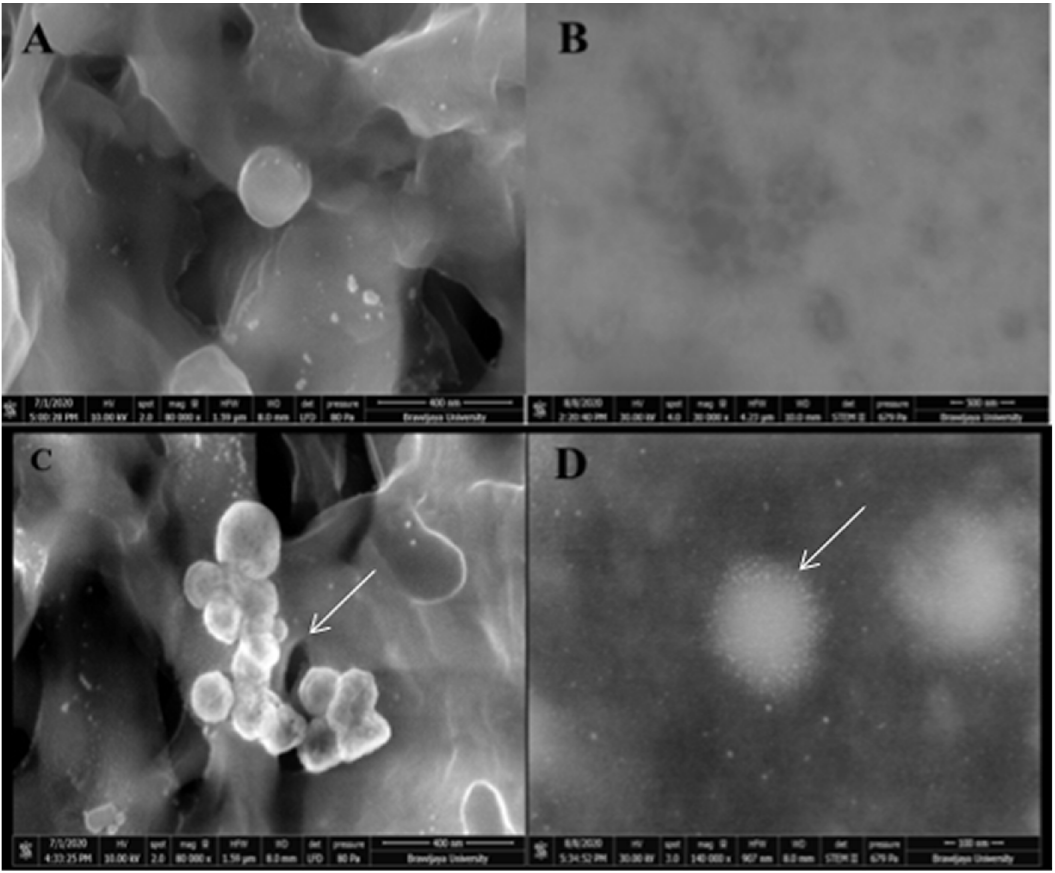
Figure2.Theresultofscanningtransmissionelectronmicroscopy(STEM)(A,B)uninfectedcellsmediumacted as a blank control; (C, D) the morphology of severe acute respiratory syndrome coronavirus 2